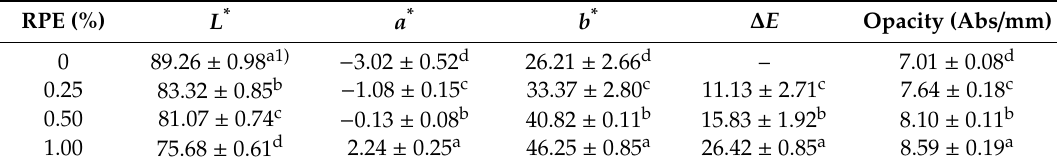
Table 4. Optical properties of CJP films containing different concentrations of RPE.